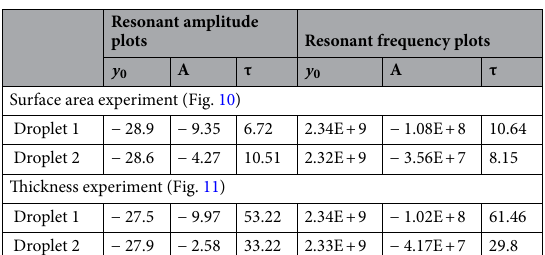
Resonant amplitude plots Resonant frequency